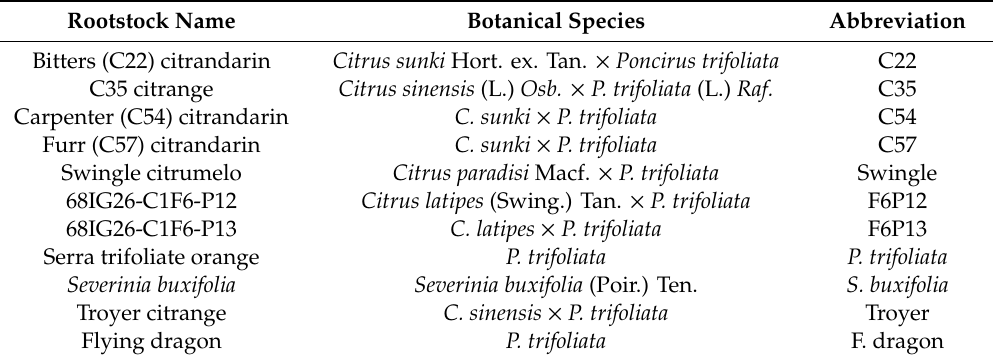
Table 1. List of rootstocks used in the field